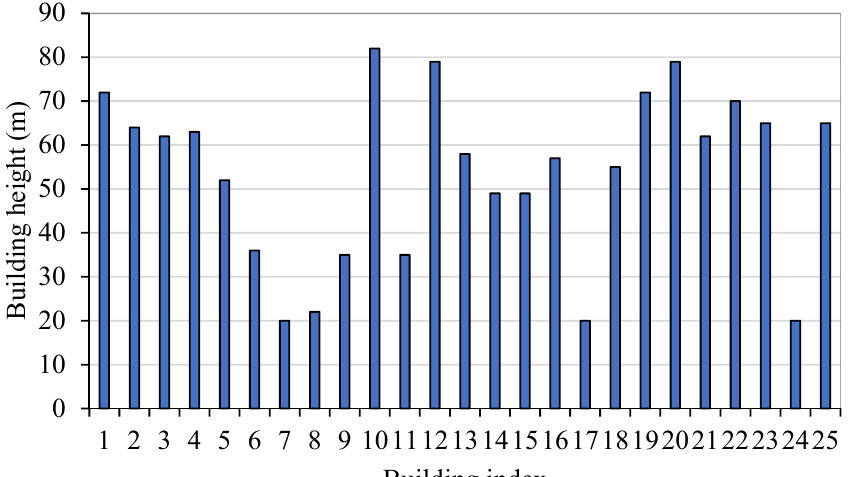
Figure 11. Heights of the selected buildings.